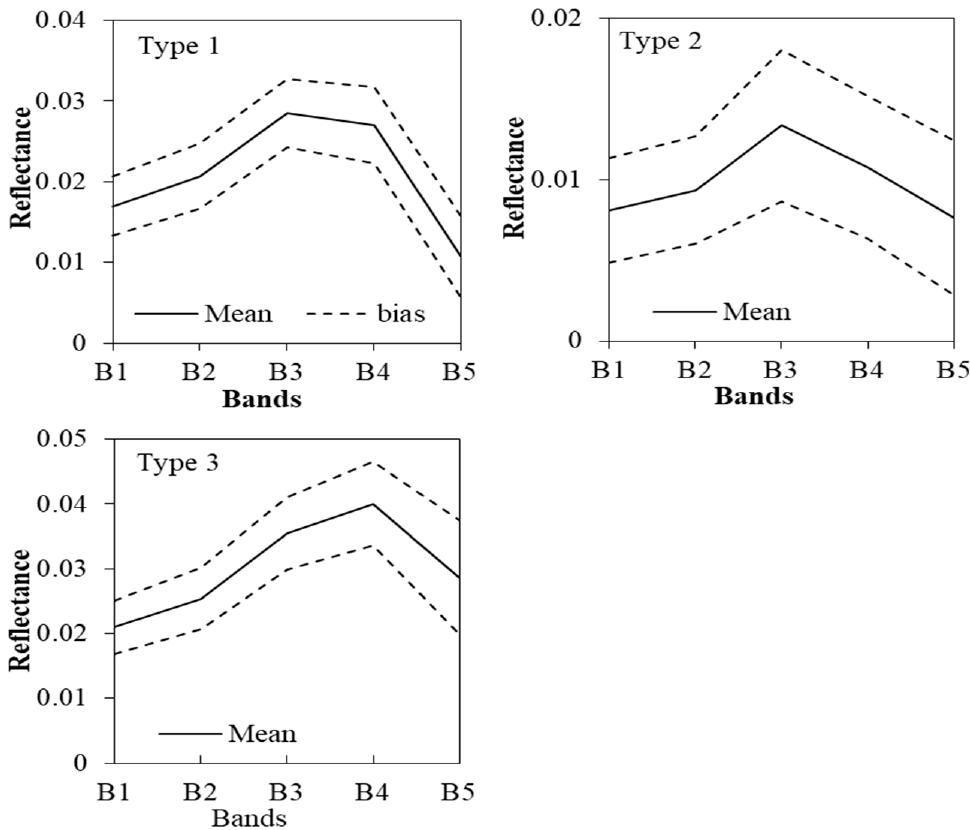
Figure 8. Average spectral curves of three optical water types generated by clustering for the study area (bands were for Landsat 8).